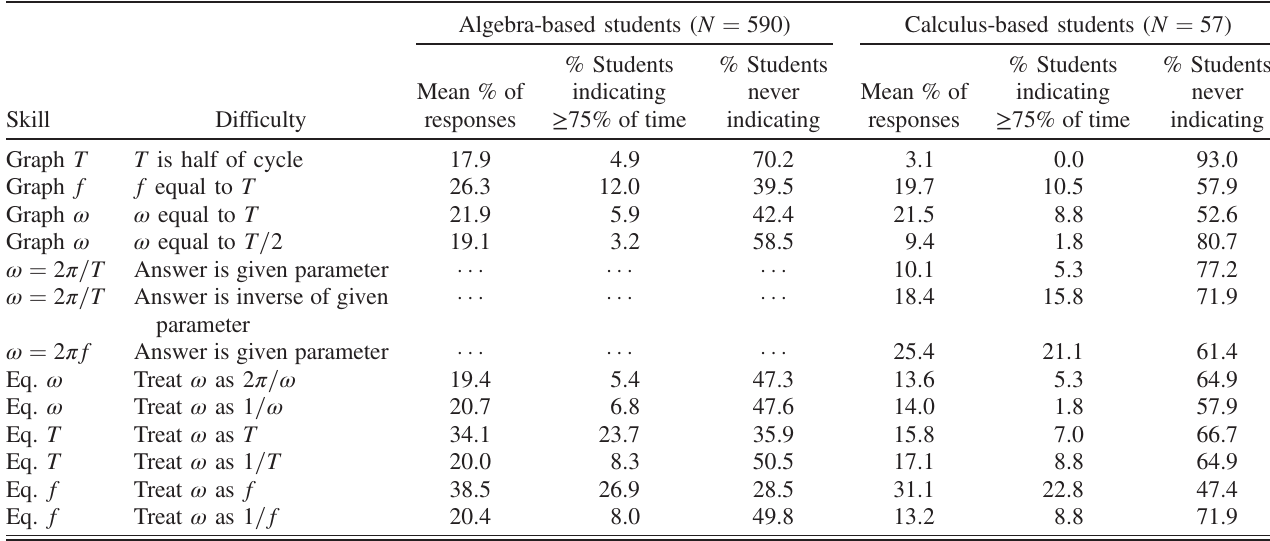
TABLE I. The mean percentage of responses indicating given difficulty, the percent of students indicating given difficulty on at least 75% of the relevant items, and the percent of students who never indicated given difficulty. Some response percentages from the algebra- based students were not included because of a confounding question format in the assessment